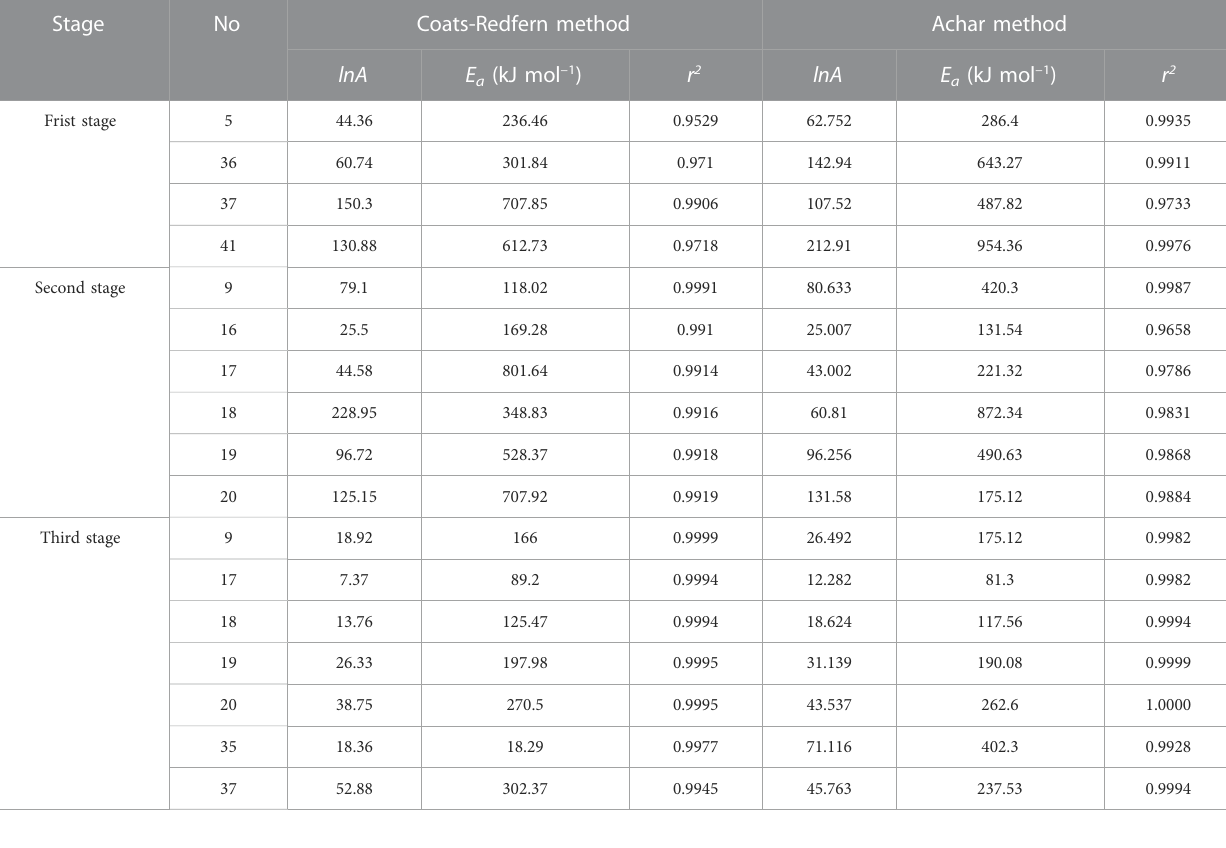
TABLE 5 Lineary dependent kinetic parameters by Achar and Coats-Redfern methods ( β = 10 K min − 1 ). Stage No Coats-Redfern method